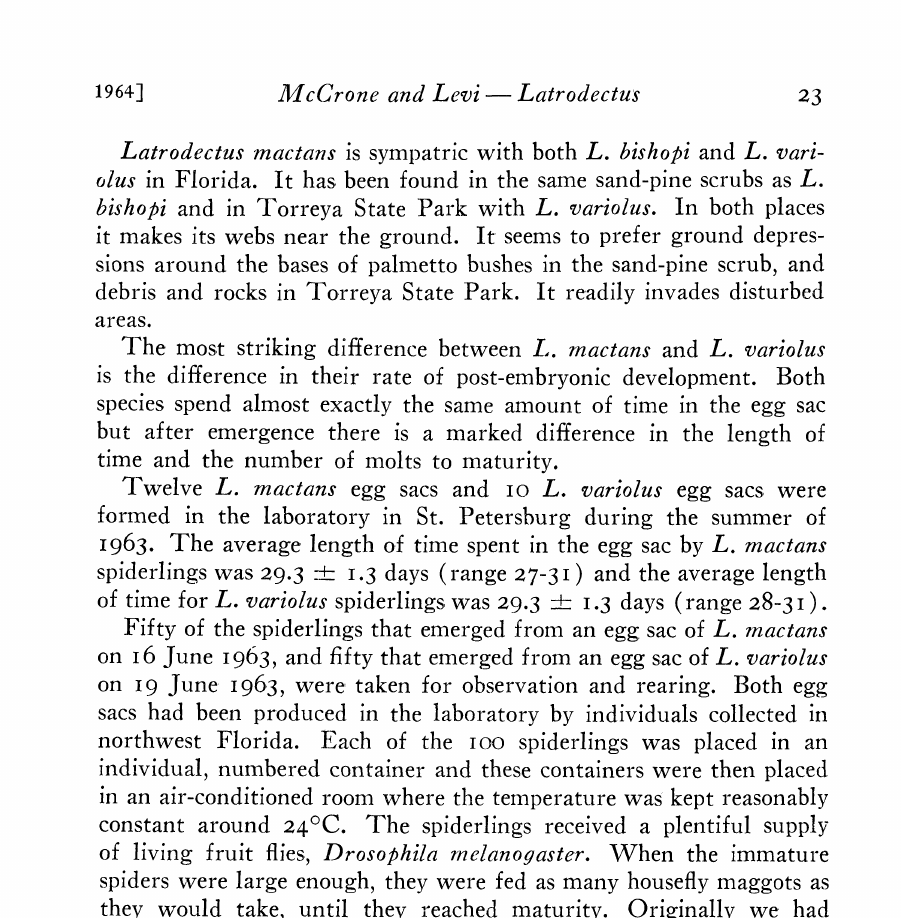
Fig. 18. Egg sacs (from left to right), Latrodectus ;ariolus, L. bisholi and L. mactans, all Florida. Fig. 19. Egg sac of L. ariolus. Fig. 20. Successive egg sacs of an individual female of Latrodectus mactans tredecimyuttatus from Israel (in Florida laboratory culture; order unknown). Figs. 21-22. Latrodectus bisholi Kaston, females. (Photograph by H. K.